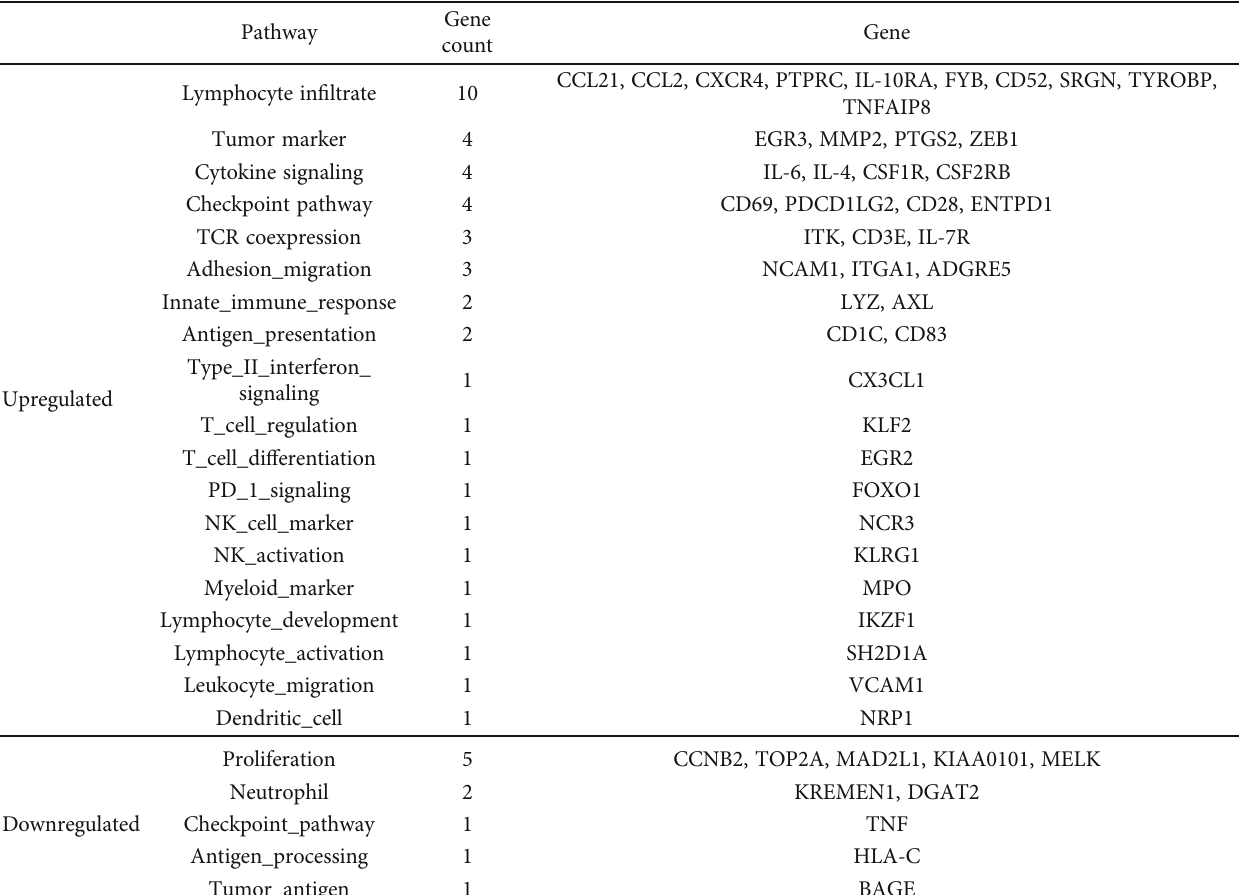
Table 2: Molecular changes after neoadjuvant